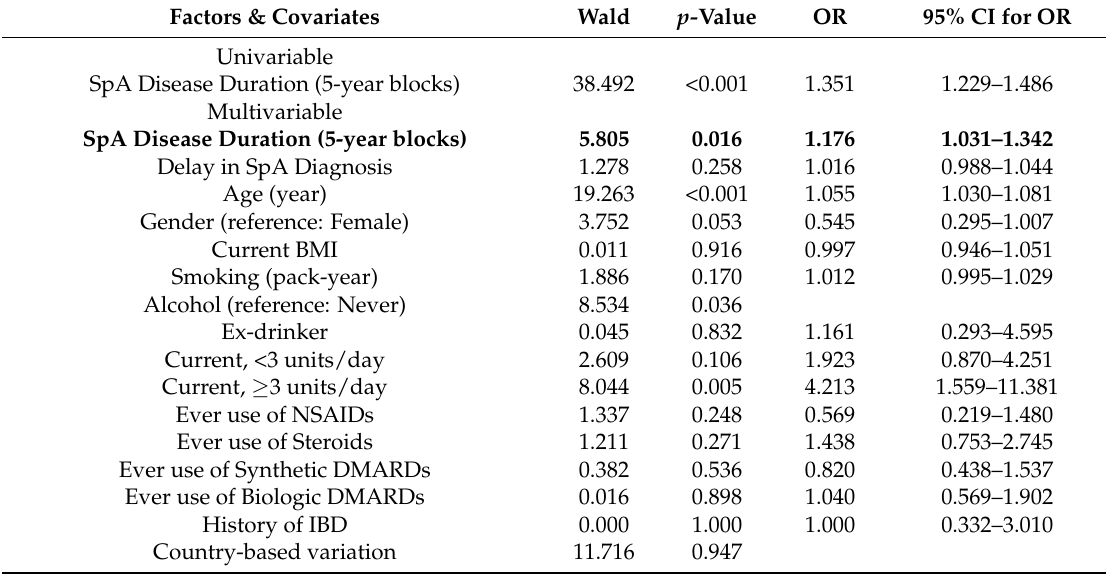
Table 2. Risk of diverticulitis associated with longer disease duration in participants with SpA.